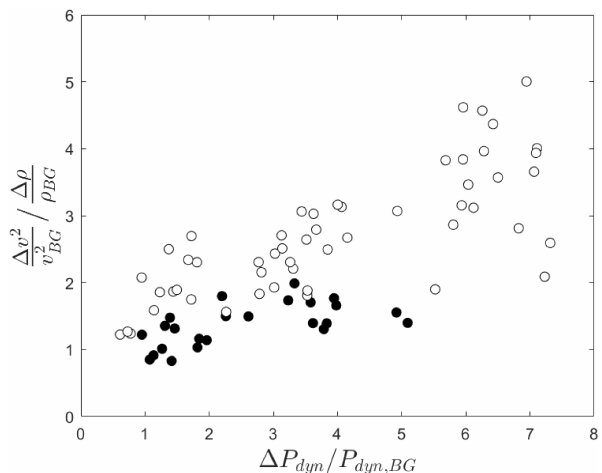
Figure 3. Relative contribution of the density changes (cid:49)ρ rel = (cid:49)ρ/ρ BG and changes in the squared velocity (cid:49)v 2 versus change in dynamic pressure (all quantities normalized to their background value). Black (white) data points are from jet no. 1 (jet no. 2), from the interval indicated in Fig.